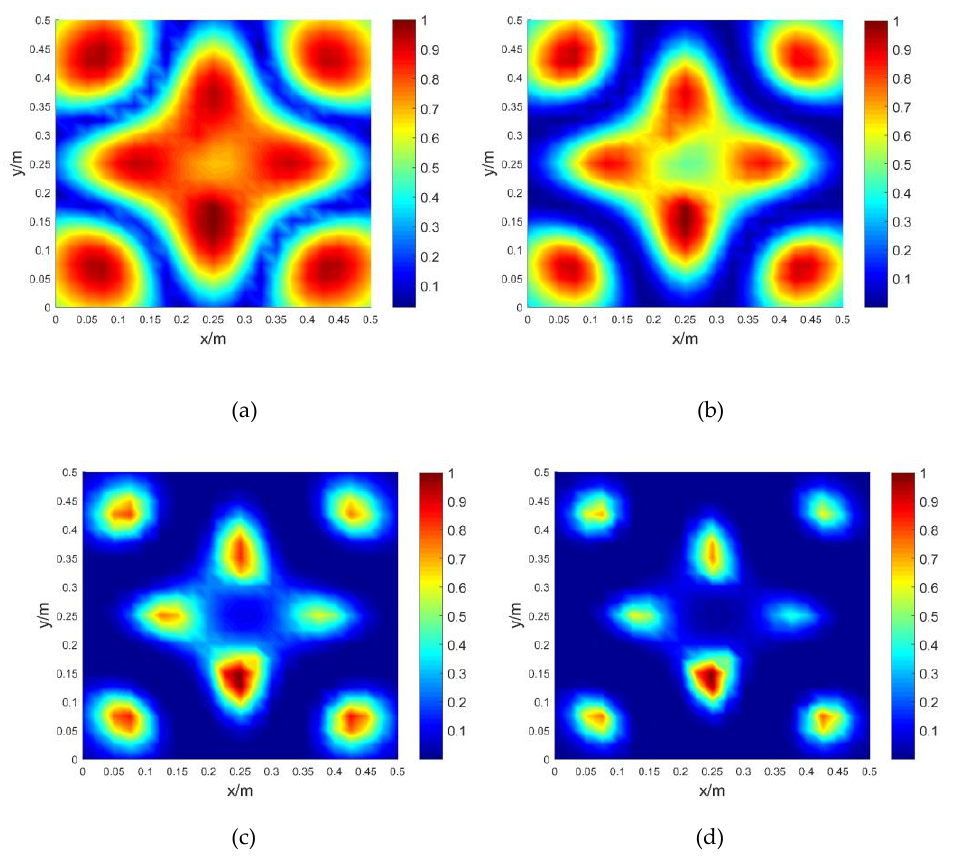
Figure 8. Pressure distributions of ( a ) ERDCESM with ν = 0, ( b ) ERDCESM with ν = 1, ( c ) ERDCESM with ν = 3 and ( d ) ERDCESM with ν = 5 for a simply supported plate at 500 Hz.